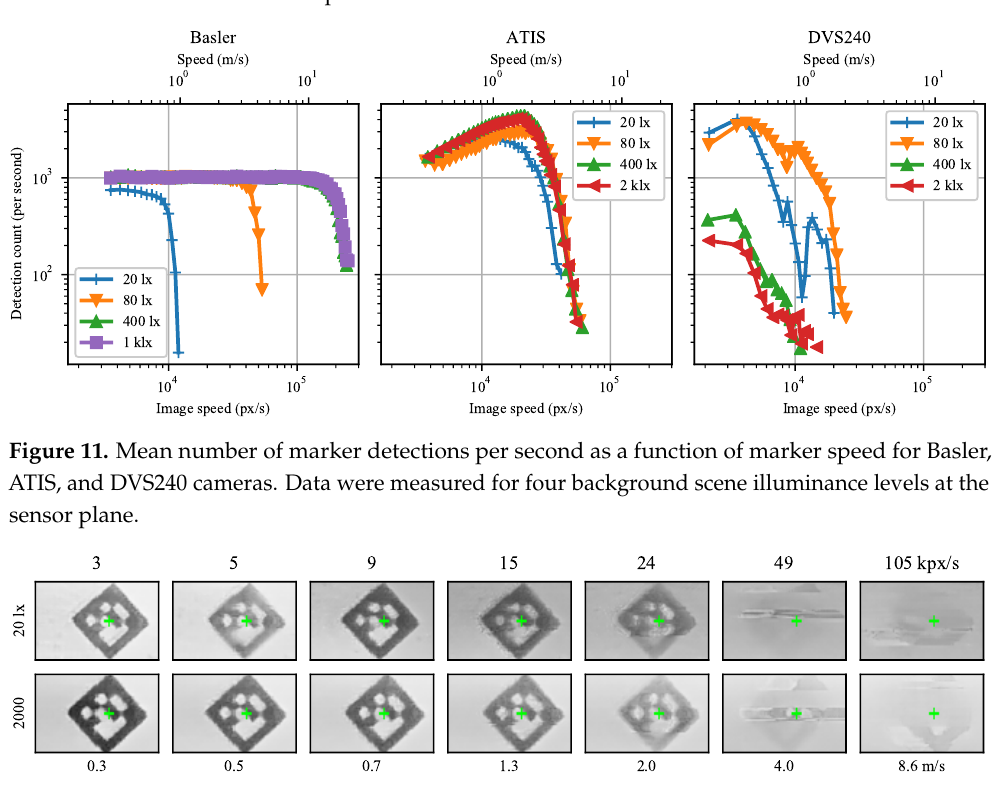
Figure 10. Mean number of marker detections per 100 pixels of marker trajectory as a function of marker speed for Basler, ATIS, and DVS240 cameras. Data were measured for four background scene illuminance levels at the sensor plane.